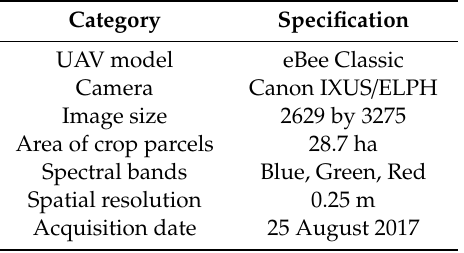
Table 1. Summary of UAV imagery used for crop classification in Anbandegi.